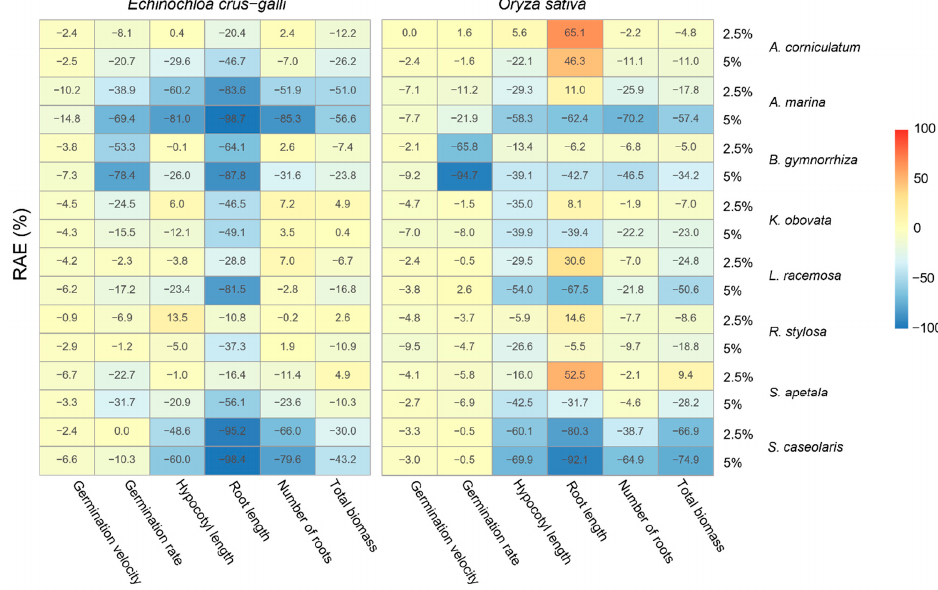
Figure 2. Heatmap representing Relative Allelopathic Effect (RAE) indices of 8 mangrove species’ ( Aegiceras corniculatum , Avicennia marina , Bruguiera gymnorhiza , Kandelia obovata , Lumnitzera racemosa , Rhizophora stylosa , Sonneratia apetala and Sonneratia caseolaris ) leaf aqueous extracts on germination (rate and velocity) and growth parameters (hypocotyl length, root length, number of roots and total biomass) of Echinochloa crus-galli and Oryza sativa seedlings 10 days after germination. The extracts were prepared at 2.5% and 5%. As for E. crus-galli , the germination velocity of O. sativa was particularly decreased when the seeds were watered with A. marina extract ( − 8% for O. sativa ) . For the germina- tion rates of O. sativa , the source species effect depended on the dose (Table 1), with seed- ling germination RAEs below − 50% for B. gymnorhiza (2.5 and 5%) and below − 20% for A. marina (5%) aqueous extracts only. For all the other tested source species and doses, the germination rate RAEs of O. sativa ranged from − 11% to +3%, two of which were found to be positive for A. corniculatum (2.5%) and L. racemosa (5%) extracts. 2.2.2. Effects on Seedling Growth The aqueous extracts of the tested species generally affected seedling growth more than germination, but these effects depended on the target species, source species and extract dose. E. crus-galli ’s hypocotyl length and biomass were significantly affected by the tested source species (F = 89.3, p < 0.01 and F = 42.0, p < 0.01, respectively) and by extract dose (F = 93.7, p < 0.01 and F = 30.1, p < 0.01). Globally, the RAEs of both parameters for this target species decreased with the higher extract dose of 5% (Figure 2). Both parame- ters were lowest when the E. crus-galli seedlings were exposed to A. marina aqueous ex- tracts, with an average RAE of − 68% and − 55%, followed by S. caseolaris ( − 52% and − 39%) and A. corniculatum ( − 14% and − 19% for extract doses of 2.5% and 5%, respectively). For